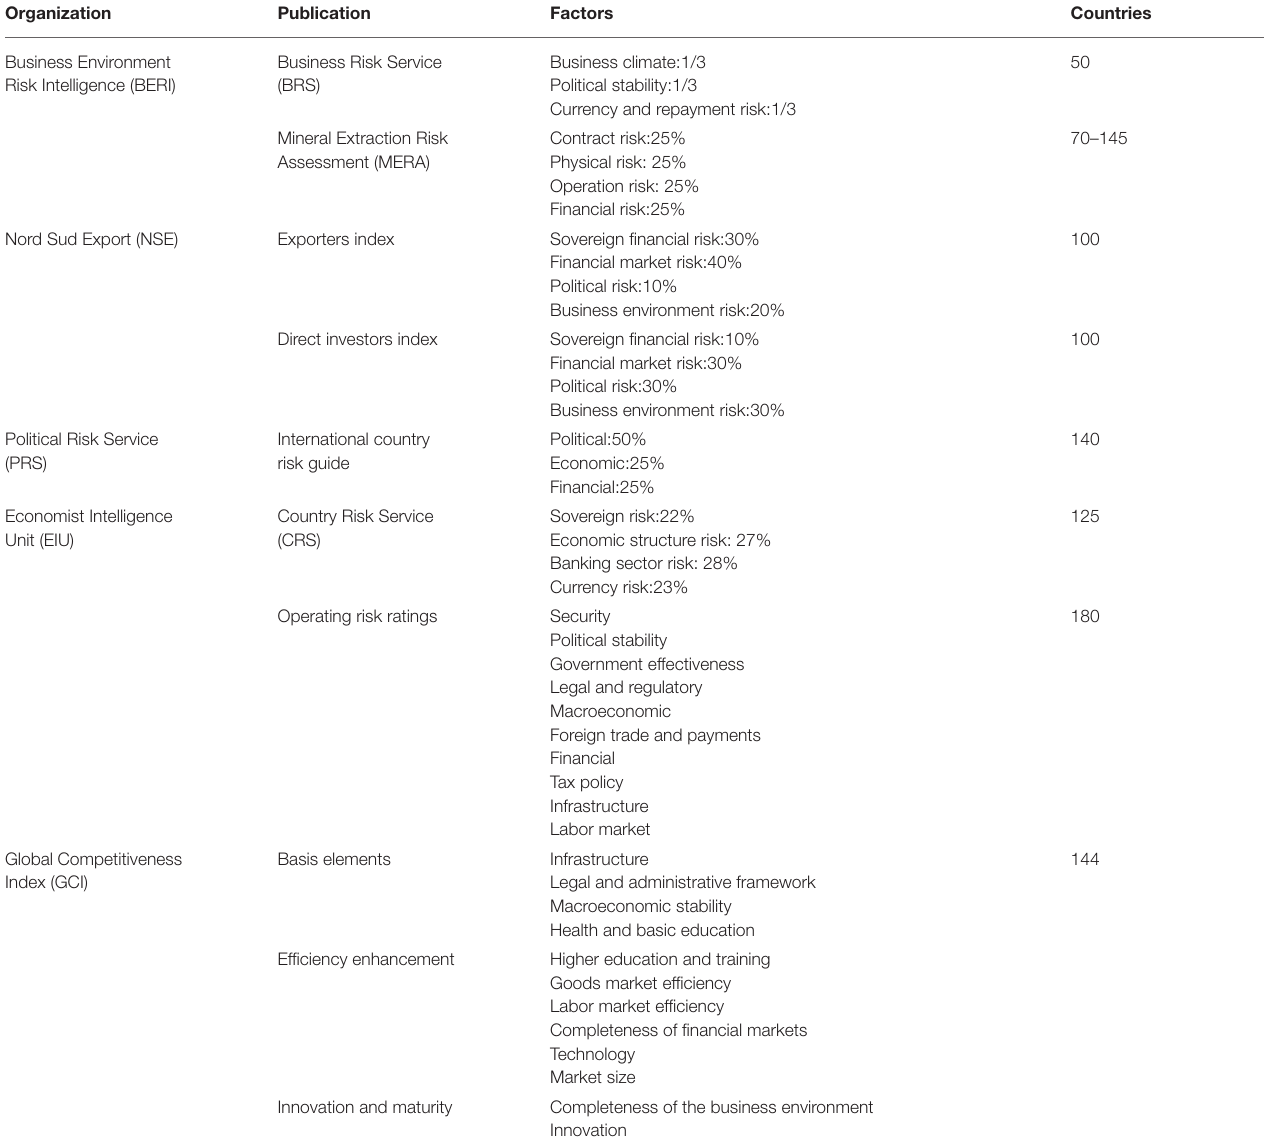
TABLE 2 | Institutions that study the overall risk of countries and their